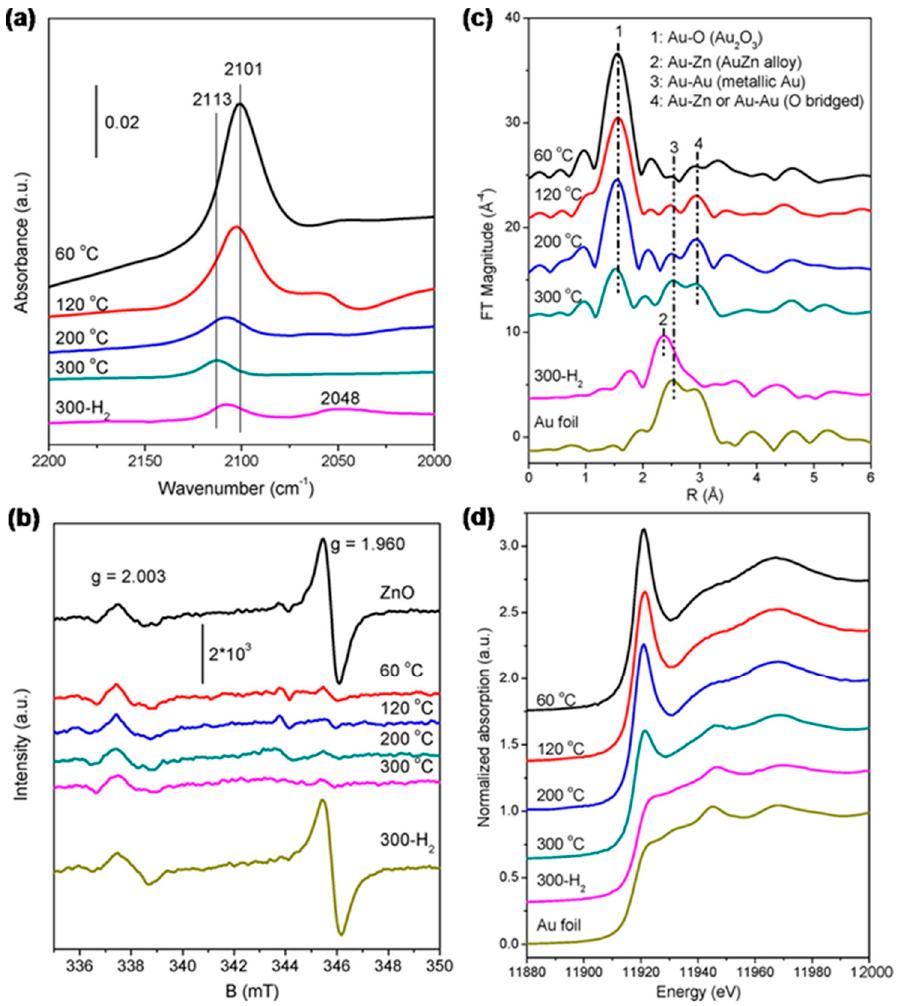
Figure 6. ( a ) In situ DRIFT spectra of adsorbed CO on Au/ZnO-nanorod catalysts; ( b ) EPR spectra of Au/ZnO-nanorod catalysts; ( c ) Fourier transform of k 3 -weighted EXAFS spectra (without phase correction) and ( d ) normalized XANES spectra at the Au L III -edge of 20Au/ZnO-nanorod catalyst. The catalysts were calcinedat 60, 120, 200, and 300 ◦ C and then reduced at 300 ◦ C. Reproduced with permission from [44], copyright: 2012 by the American Chemical